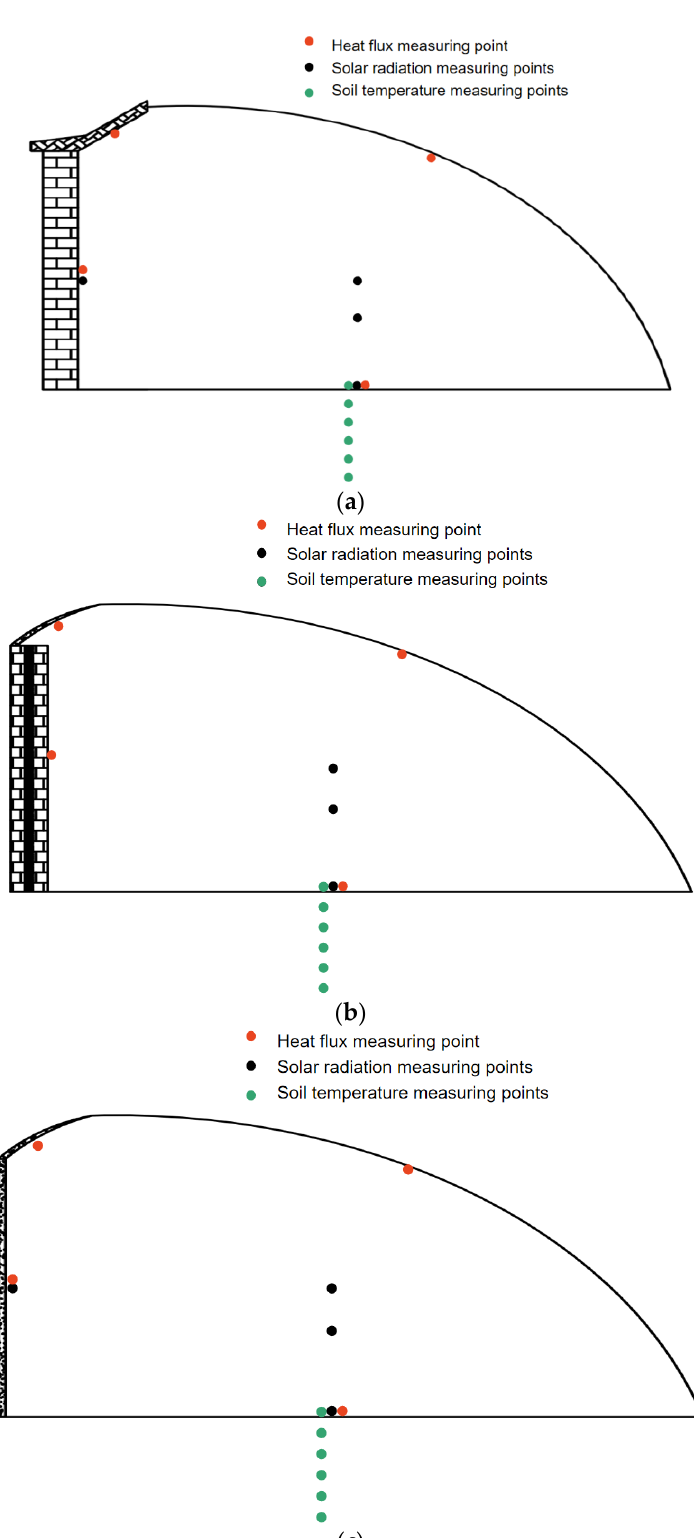
Figure 4. Distribution of environmental testing points in CSG. ( a ) Distribution of environmental testing points in G1. ( b ) Distribution of environmental testing points in G2. ( c ) Distribution of environmental testing points in G3.